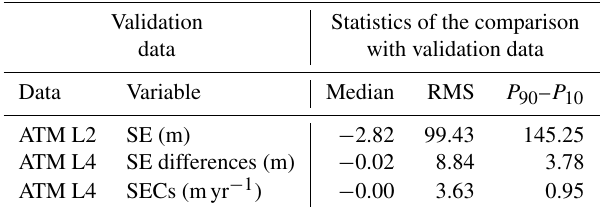
Table 1. Statistics of the results of validation with ATM laser al- timeter observations. The median, RMS error, and P 90 – P 10 of the biases are